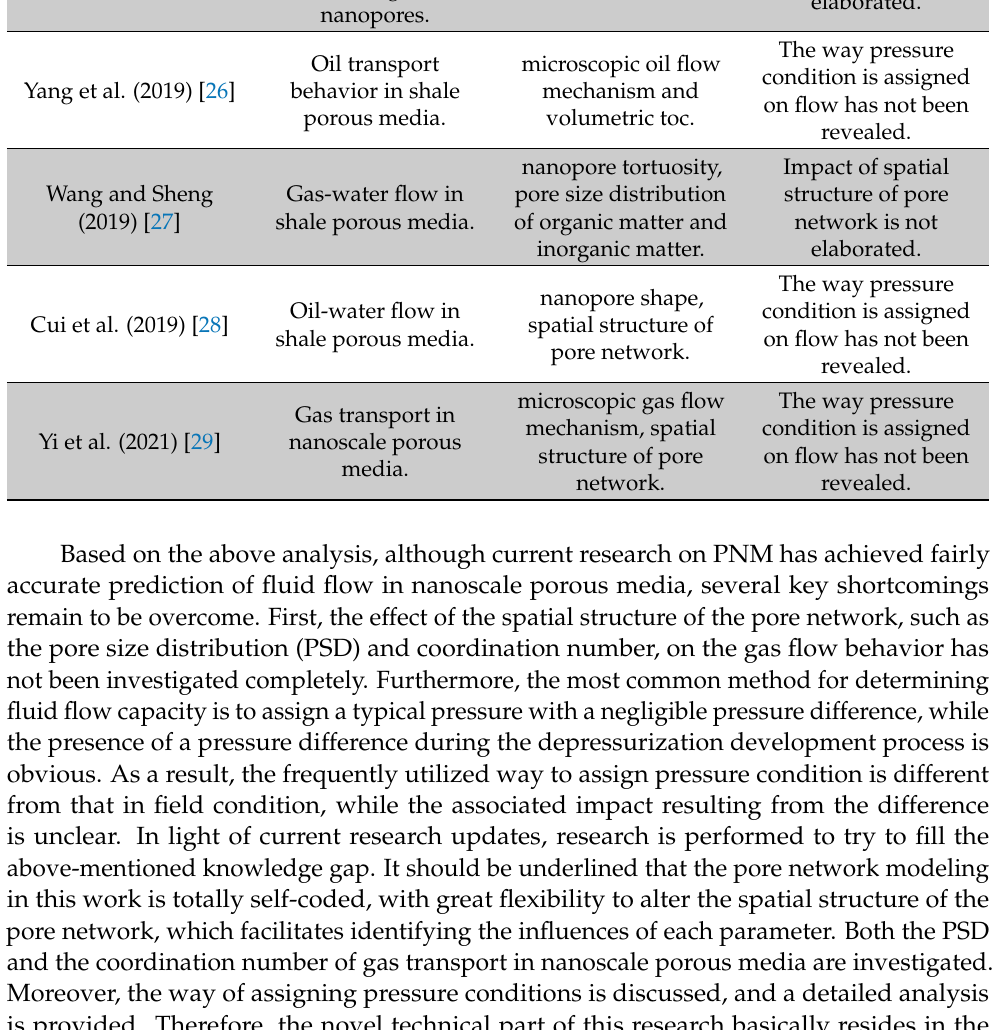
Gas transport behavior in porous media constructed by shale organic nanopores.